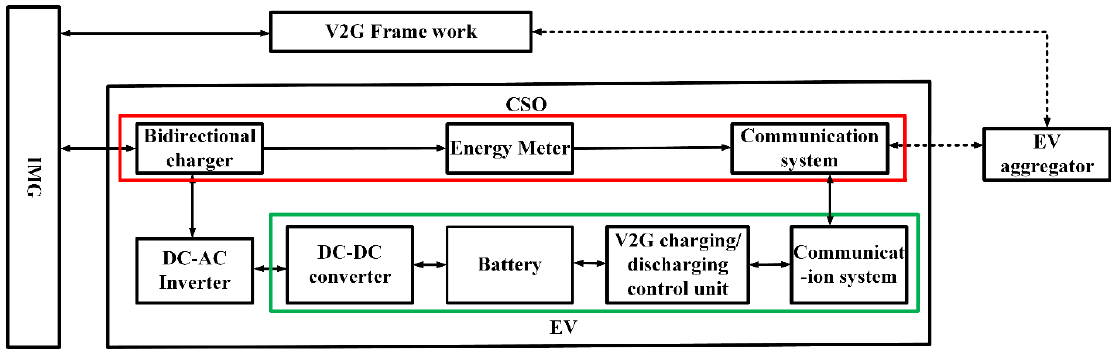
Figure 4. CSO and V2G framework for the primary frequency control (PFC) of an industrial